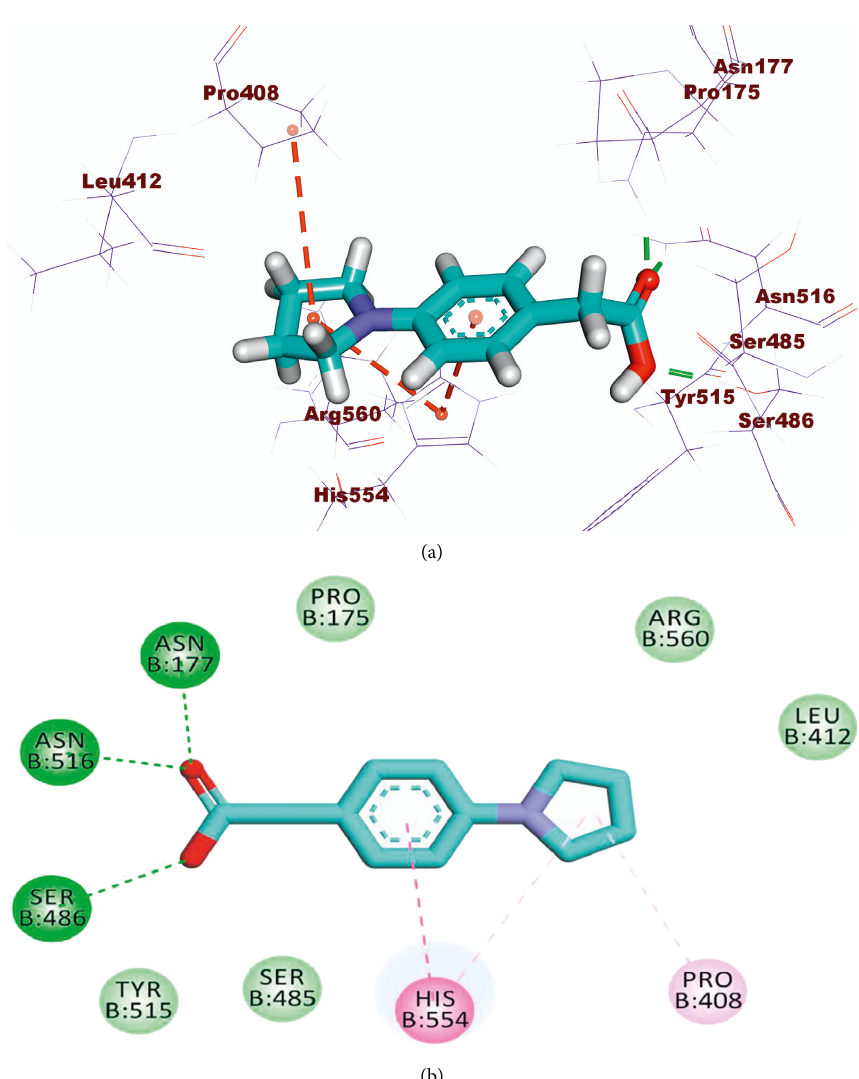
Figure 8: (a) 3D and (b) 2D images of the docked compound 84 into the active site of SARS-CoV-2